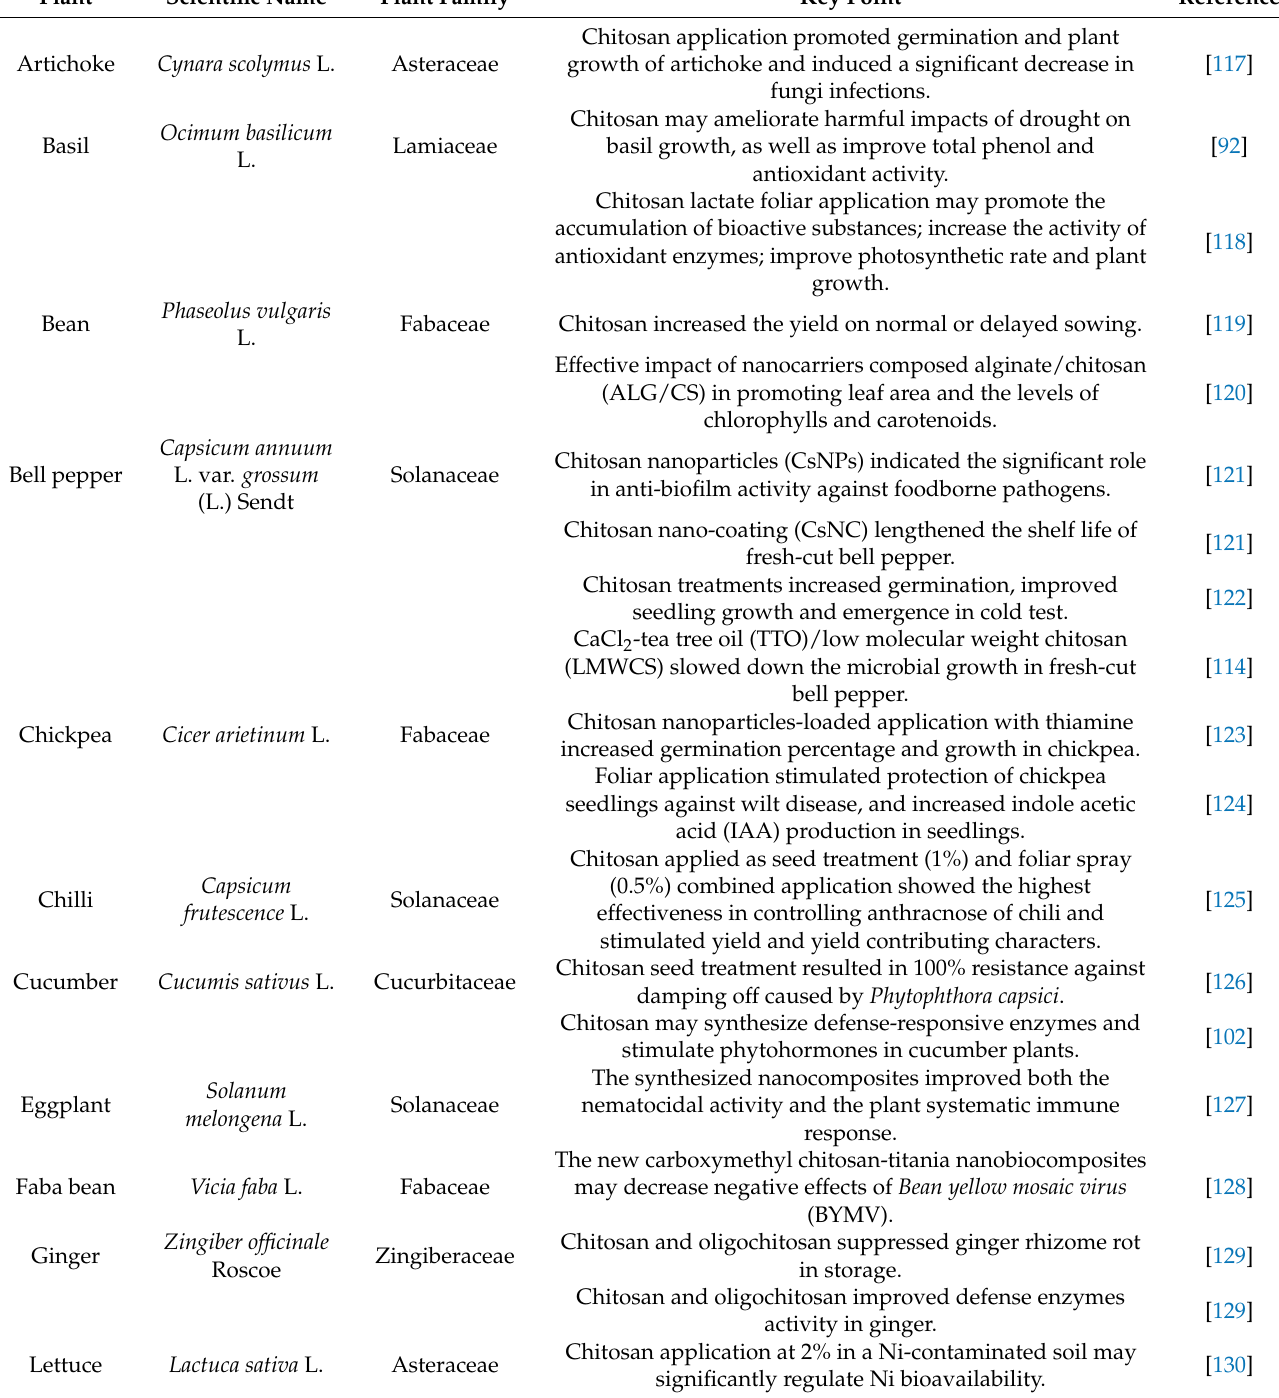
Table 1. The effects of chitosan on vegetable